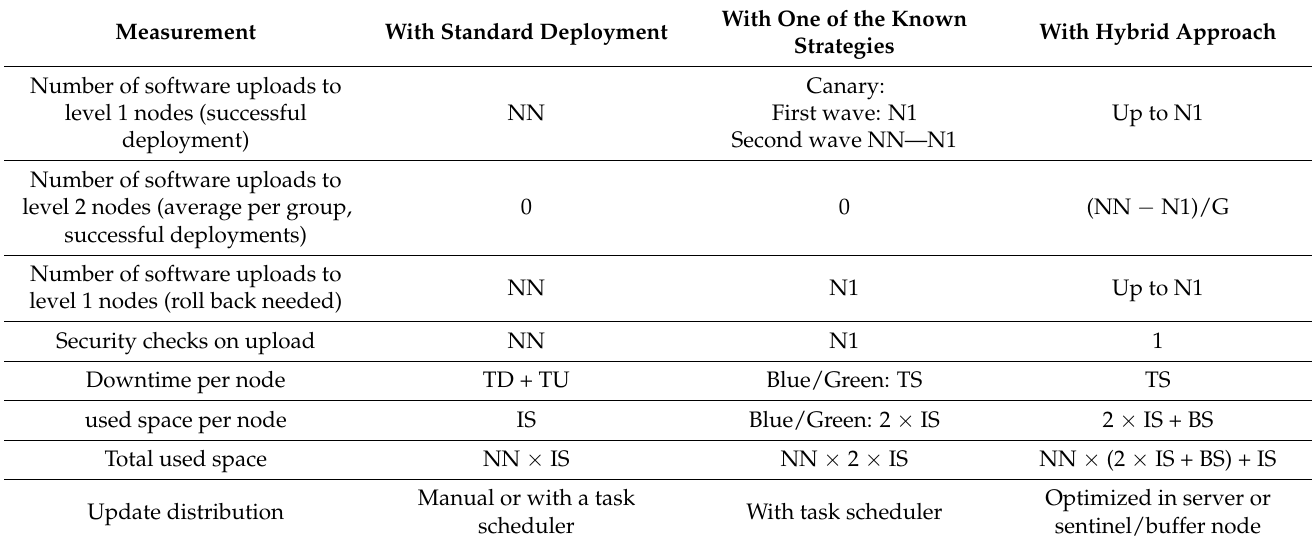
Table 6. The estimated effects of the proposed deployment strategy (TD—time to shut down the software in the node, TU—time to start the software in the node, TS—time switch between the versions, IS—software instance size per node, BS—buffer size, NN—total number of nodes, N1— number of level 1 nodes, G—number of level 2